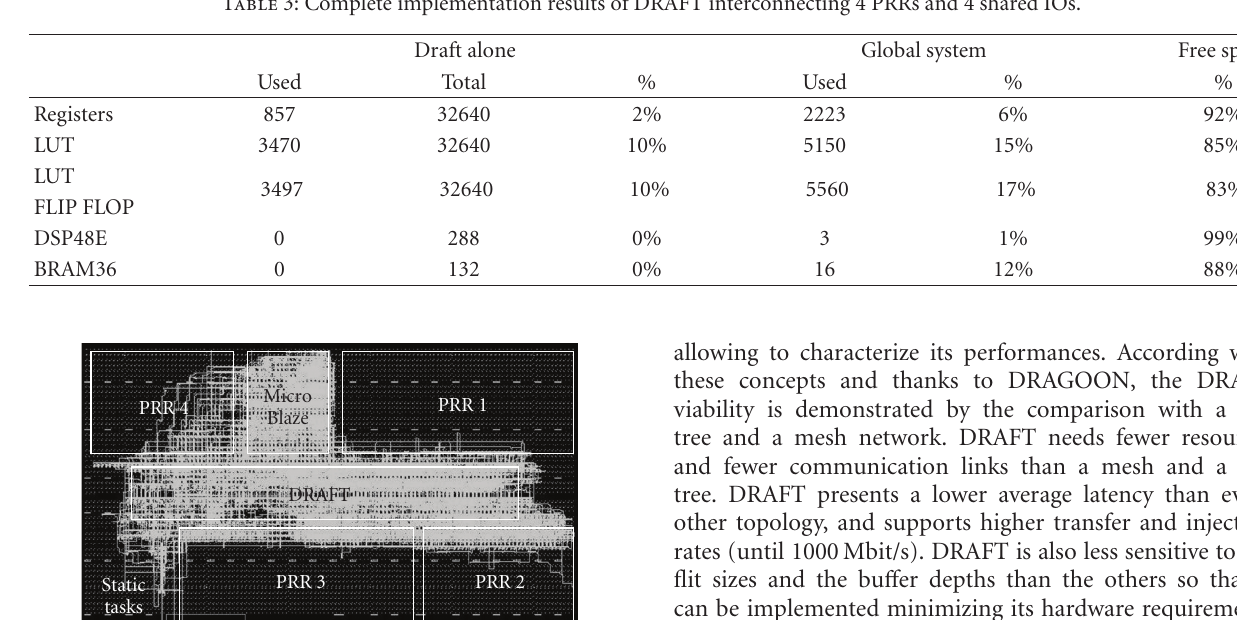
Table 3: Complete implementation results of DRAFT interconnecting 4 PRRs and 4 shared IOs.